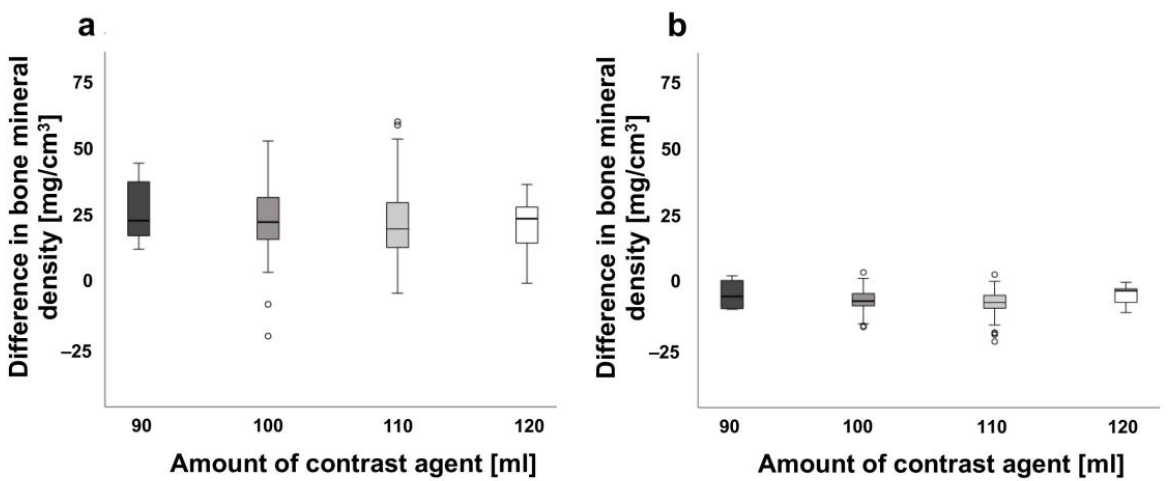
Figure 4. Difference of bone mineral density (BMD) between amount of contrast agents and location. ( a ) Shows the difference of BMD between the amount of contrast agents [mL] (minimum 90 mL to maximum 120 mL) for the spine (n = 127) and ( b ) for the proximal femur (n = 70). Bone mineral density of patients in mg/cm 3 shown on the y-axis, amount of contrast agents [mL] are presented on the x-axis. Median values are shown. Combined diagram for both sexes.